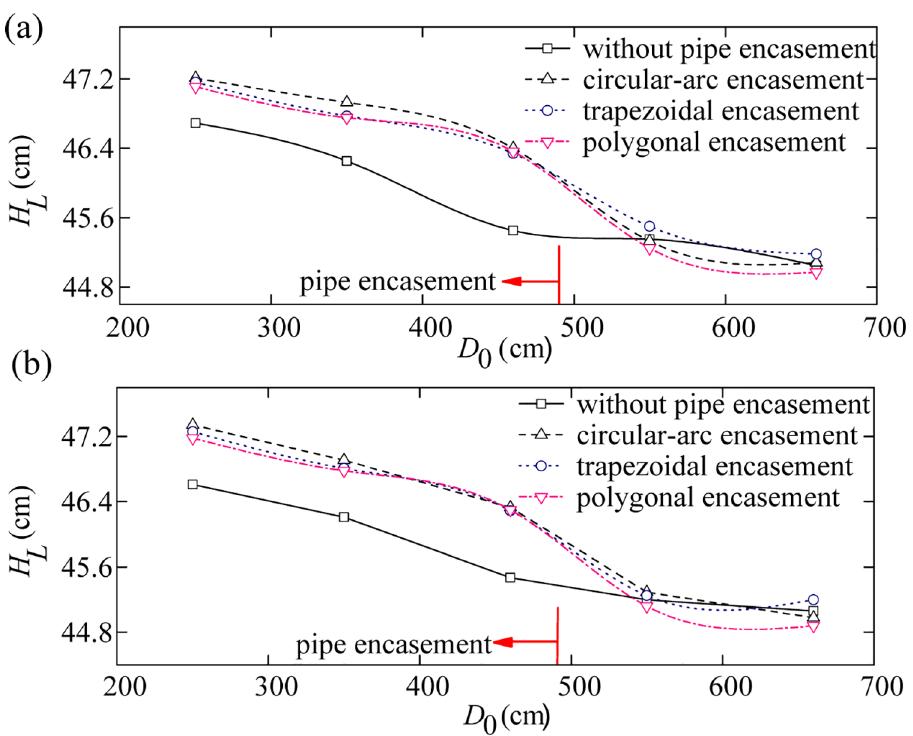
Fig 4. Water level curves on the left bank (a) and the right bank (b) for an annual discharge.